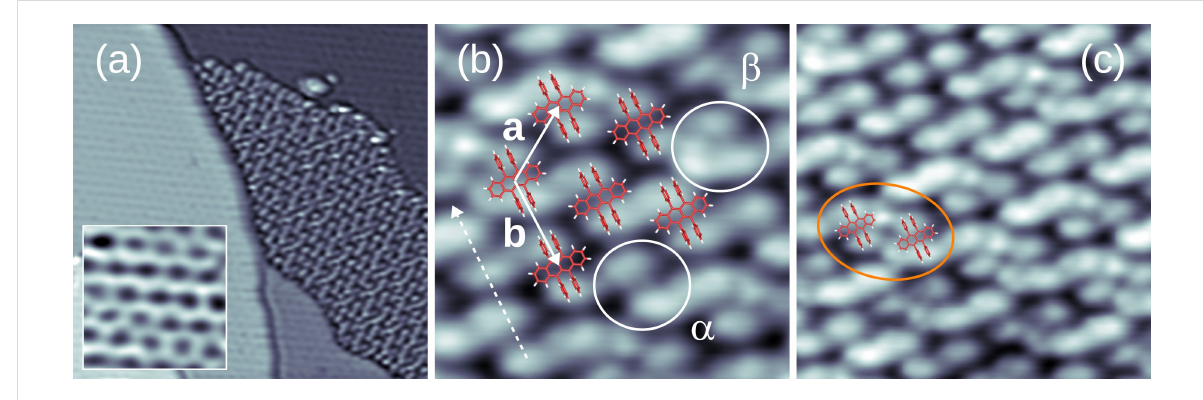
Figure 6: (a) STM image of C 42 H 28 molecules on graphene-covered Pt(111) (2 V, 100 pA, 34 × 34 nm 2 ). Inset: Close-up view of clean graphene with moiré pattern (5 × 5 nm 2 ). (b) Close-up view of a molecular island (2 V, 20 pA, 6 × 6 nm 2 ). Molecular sketches (to scale) of the C 42 H 28 molecules are superimposed. The unit cell vectors a and b of the C 42 H 28 lattice are indicated as arrows. The dashed arrow marks a crystallographic direc- tion of graphene. Molecules with planar ( α ) and twisted as well as tilted ( β ) configuration are encircled. (c) Close-up view of molecular rows of mole- cules with twisted and tilted configuration (2 V, 20 pA, 8.3 × 8.3 nm 2 ). The ellipse indicates a pair of molecules with twisted and tilted